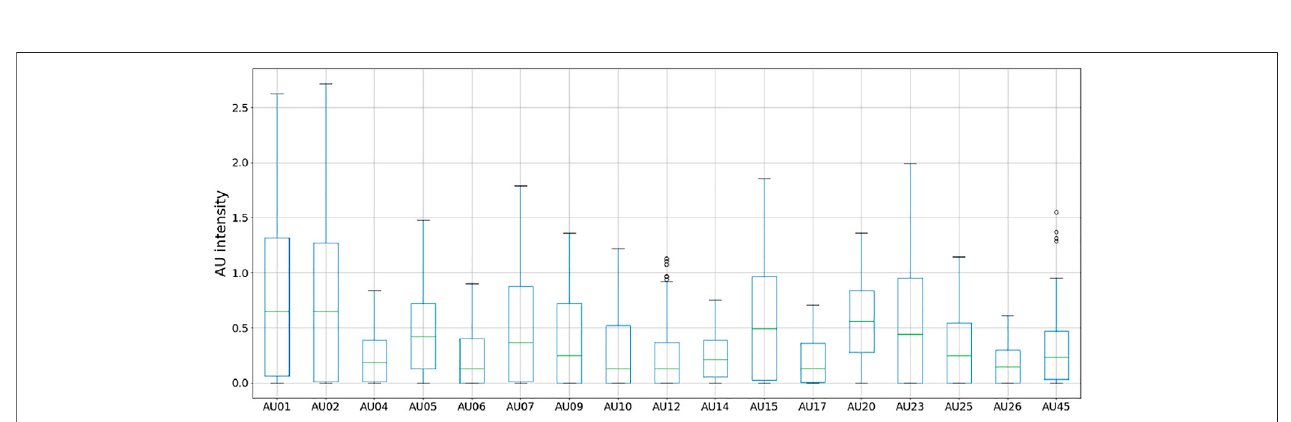
FIGURE 6 | Distribution of AU intensities captured from the fi nal 500 random face-servo positions.